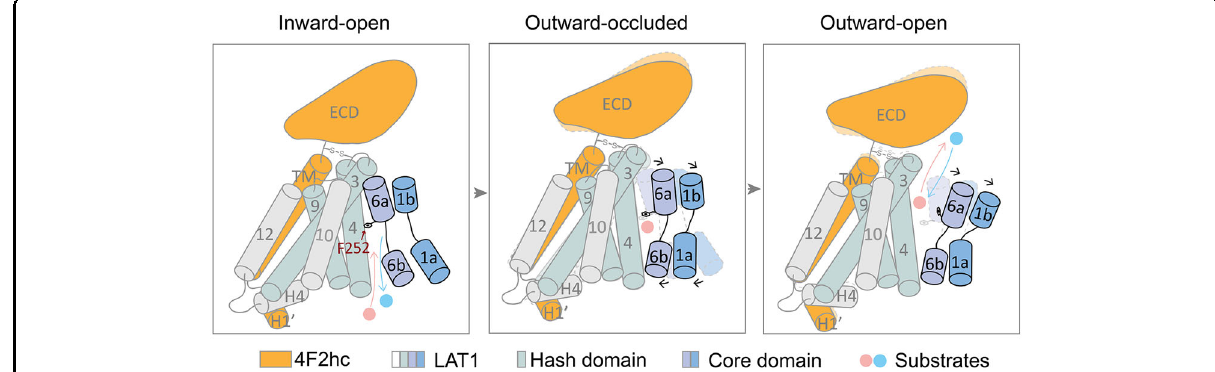
Fig. 6 Putative working model for the LAT1-4F2hc complex. The model shows a transport mechanism of LAT1. LAT1 loads substrates in cytoplasm and then TM1a and TM6b rotate to the hash domain to close the inward gate. During the transition from the inward-facing conformation to the outward-facing conformation, TM1a and TM6b continue to rotate and TM1b and TM6a start to rotate away from the hash domain. Then TM1b and TM6a undergo further rotation and push the gating residue Phe252 away from the occluded con fi guration, triggering substrate release. For simplicity, TM2 and TM7 of the core domain and TM8 of the hash domain are not shown here. ECD, extracellular domain. H, helix. TM, transmembrane